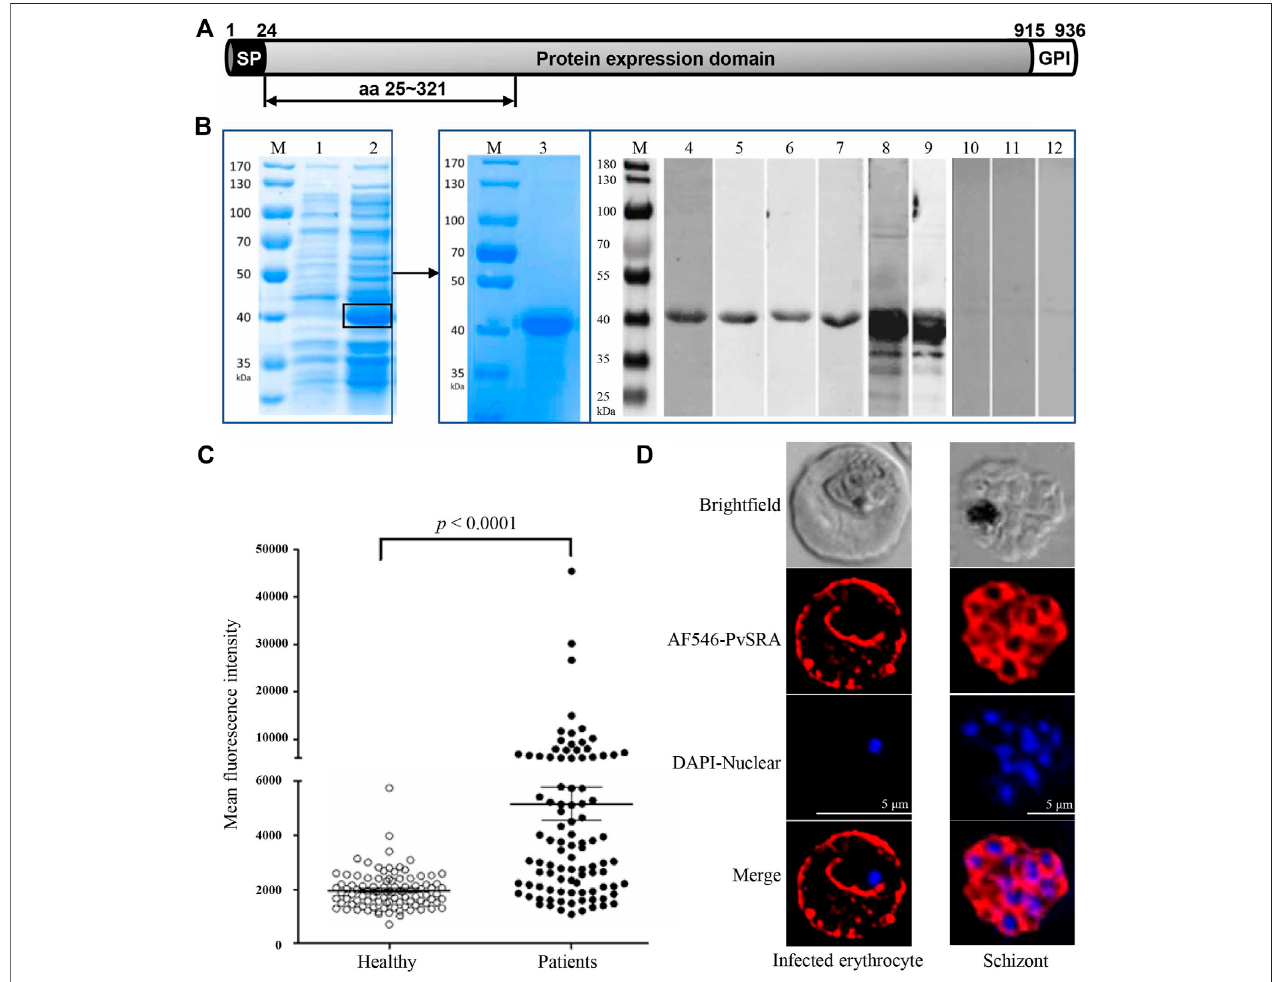
FIGURE 1 | Expression of recombinant PvSRA and location of PvSRA on infected erythrocytes. (A) Schematic diagram of gene sequence of PvSRA. PvSRA consists of a signal peptide (SP) [amino acids (aa) 1 – 24], a protein expression domain (aa 25 – 914), and a GPI-anchored domain (aa 915 – 936). The functional region of PvSRA with a total of 297 aa (aa 25 – 321) was expressed in E. coli BL21 in present work. (B) Expression of PvSRA functional region protein. The recombinant PvSRA proteinwasdetected byanti – 6 × His-tagantibodyandspeci fi cserainWBanalysis.M,Proteinmarker;lane1, E.coli BL21straincontainingpET28a-PvSRA;lane2, BL21 cell containing pET28a-PvSRA with 0.5 mM IPTG induction; lane 3, SDS-PAGE analyses for the puri fi ed PvSRA; lane 4, WB analyses for the puri fi ed PvSRA with anti-6 × Hisantibody;lanes5 – 7,serapreparedfromthree P.vivax – infectedpatients;lane8,speci fi cserapreparedfromrabbit;lane9,speci fi cserapreparedfrommouse; lane10,sera from healthy individual;lane 11,sera from normal rabbit; and lane12, serafrom normal mouse. (C) Comparison ofIgG antibody responses torecombinant PvSRA proteins. Sera samples from P. vivax – infected patients ( n (cid:2) 96) and healthy individuals ( n (cid:2) 96) were used for measurement of antibody responses by protein array. The bar indicates mean value and 95% con fi dence interval. MFI, mean fl uorescence intensity. (D) Localization of PvSRA protein in the erythrocytic and mature schizont stages of P. vivax parasites by using the speci fi c rabbit antisera against PvSRA and Alexa Fluor 546 – conjugated goat anti-rabbit IgG. Nuclei are visualized with DAPI in merged images. Bars represent 5 μ